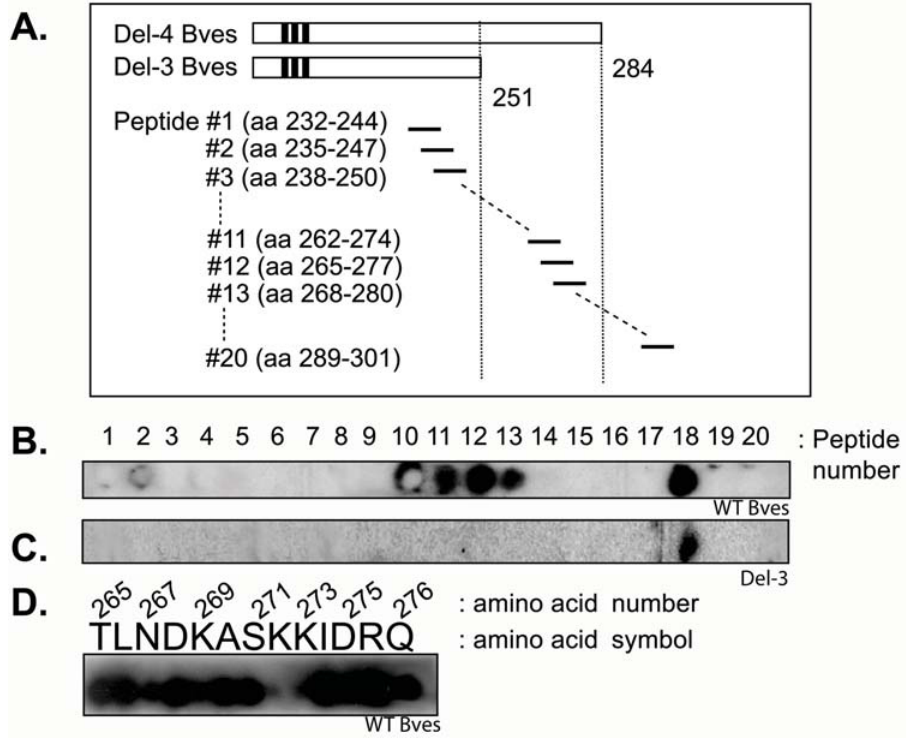
Figure 2. SPOTs protein mapping. A, Diagram of SPOTs blot (synthesized peptides). Twenty 13-mer peptides (SPOTs) were synthesized from the sequence of C-terminal Bves (amino acids 232-301) and fixed on a cellulose membrane for reaction with WT Bves or Del-3 Bves. B, Spots binding assay with WT Bves. A binding with WT Bves is clearly detected with peptides 11-13. Peptide 10 is likely a false positive, since the signal appears circumferential to the spot of protein. An additional unpredicted reaction is detected with peptide 18. C, Spots binding assay with Del-3 Bves. No binding of Del-3 Bves is detected with peptides 11-13 while peptide 18 is reactive suggesting a non-specific or interaction domain-independent association. D, Alanine substitution analysis. Numbers over the amino acid symbols are the amino acid number of WT Bves. Peptide 12, that showed positive binding at panel B was substituted at each amino acid position with alanine and incubated with WT Bves cell lysate. Substitution of lysines at positions aa 272 and aa 273 with alanine abolished binding with WT Bves